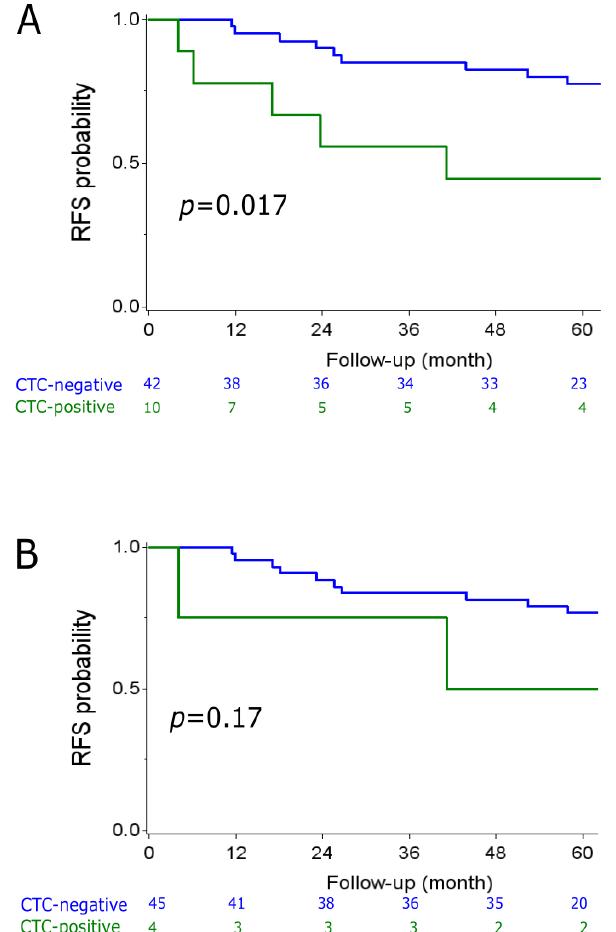
Figure 2. Kaplan–Meier curves for relapse-free survival (RFS) depending on the CTC status (green = CTC-positive; blue = CTC-negative). ( A ): CTC status at baseline. ( B ) CTC status after one cycle of treatment. p = Log-rank p -value.